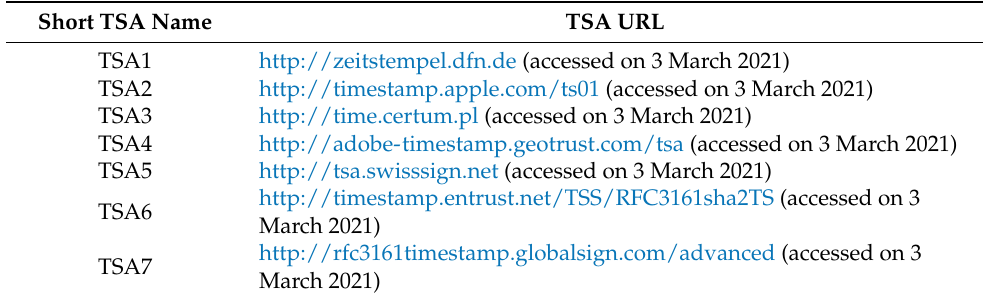
Table 2. Free timestamping